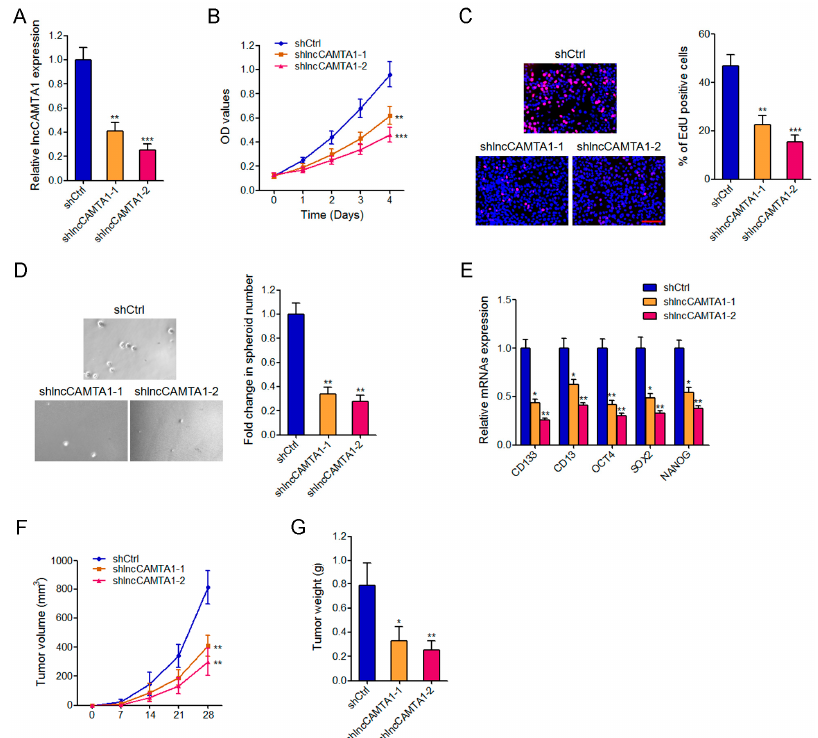
Figure 5. Depletion of lncCAMTA1 inhibits HCC cell proliferation, CSC-like properties, and tumorigenesis. ( A ) lncCAMTA1 expression in lncCAMTA1 stably depleted and control HepG2 cells; ( B ) Cell proliferation of lncCAMTA1 stably depleted and control HepG2 cells was detected by CCK-8 assay, and the relative number of cells compared to day 0 is presented; ( C ) Cell proliferation of lncCAMTA1 stably depleted and control HepG2 cells was detected by EdU incorporation assays. Scale bar = 100 μ m; ( D ) Spheroid formation assays showed that knockdown of lncCAMTA1 decreased the number of spheroids generated from HepG2 cells; ( E ) Depletion of lncCAMTA1 downregulated the expression of stem cell markers and transcription factors CD133, CD13, OCT4, SOX2, and NANOG. For A – E , data are shown as mean ± SD. * p < 0.05, ** p < 0.01, *** p < 0.001 by Student’s t test; ( F , G ) Depletion of lncCAMTA1 inhibited in vivo tumor growth of HepG2 cells. lncCAMTA1 stably depleted and control HepG2 cells were subcutaneously injected into nude mice. Tumor volumes were measured every 7 days ( F ), and tumor weights were measured at 28 days after injection ( G ). n = 6 mice in each group, * p < 0.05, ** p < 0.01 by Mann–Whitney test.